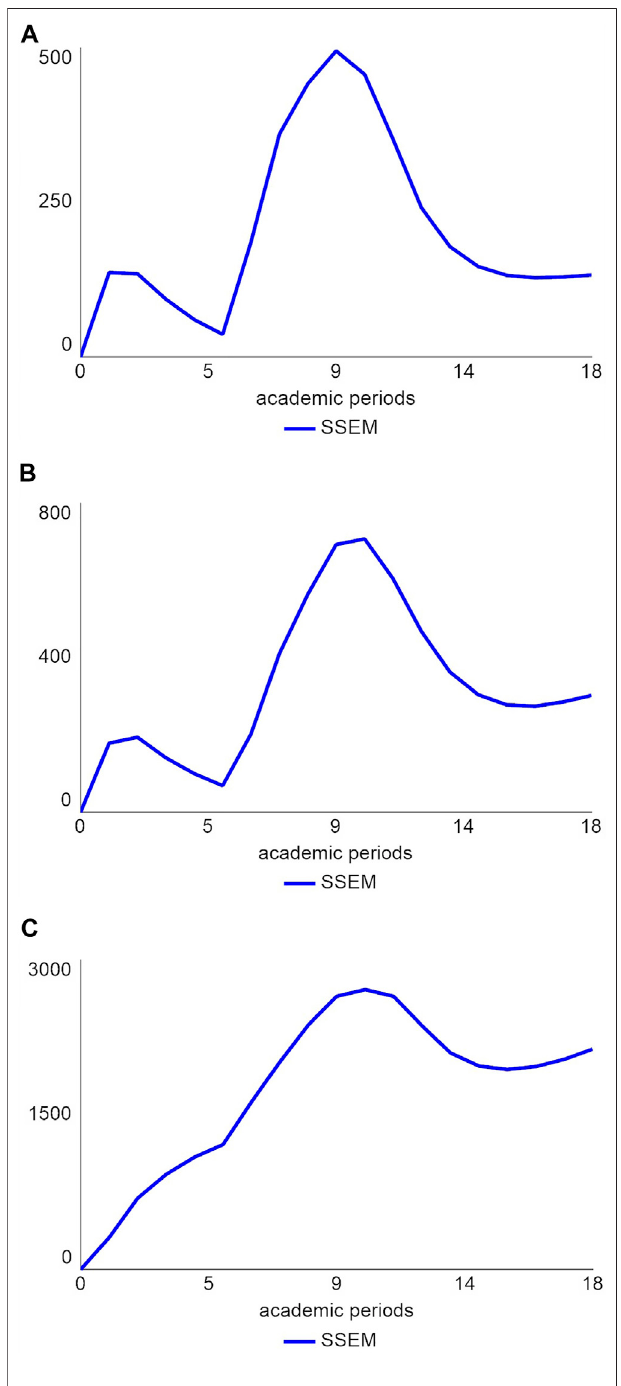
FIGURE2| Drop-outbehaviourbyacademicperiodforSIM-1.Note: (A) presents technical training programmes, (B) technology training and (C) professional training. SEM: Total number of dropouts per academic